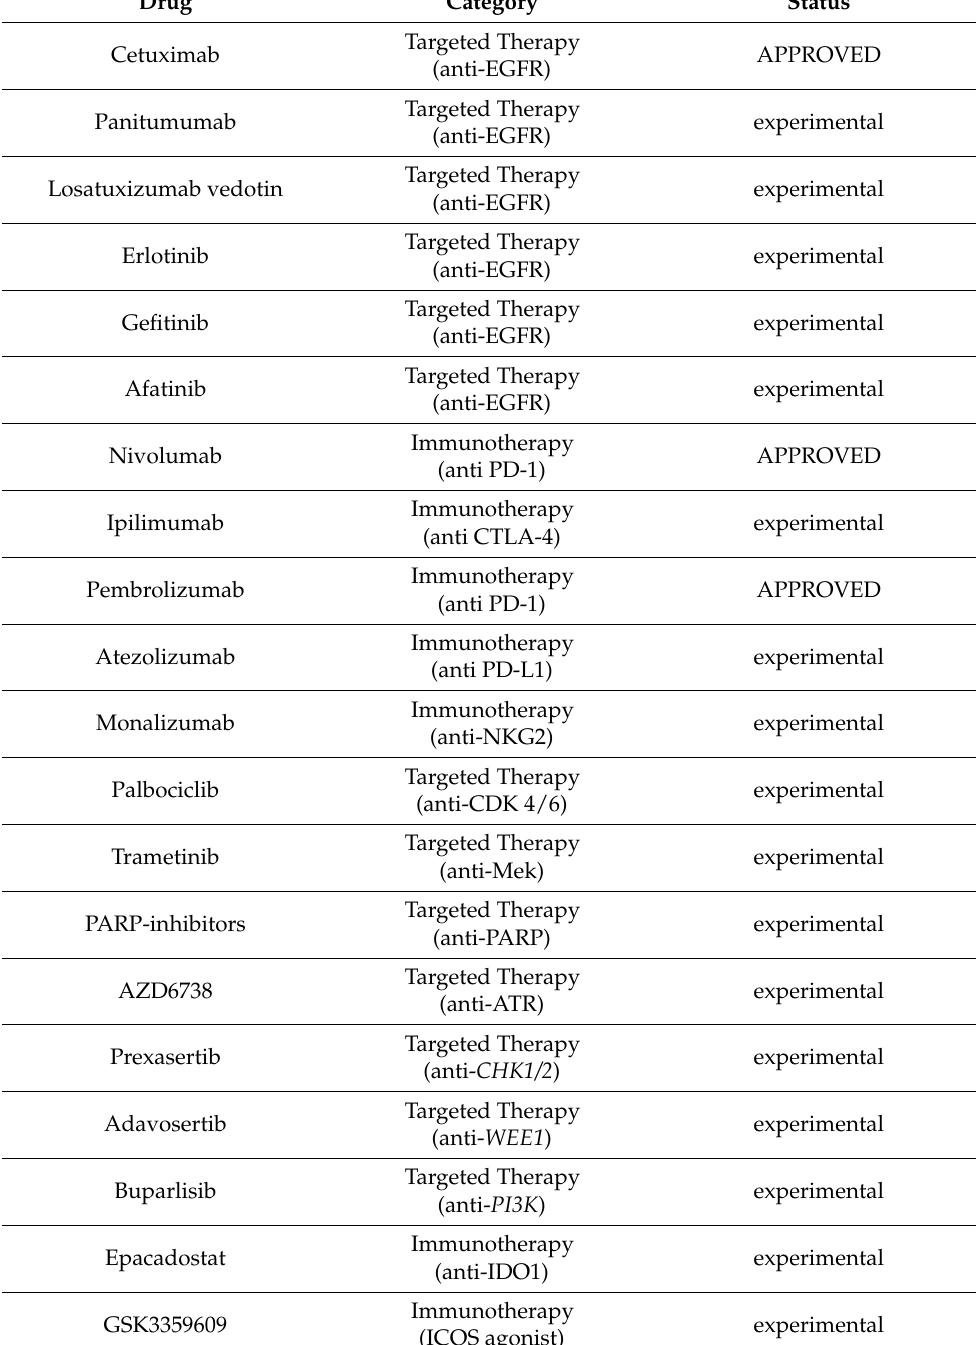
Table 1. Drugs employed in HNSCC.